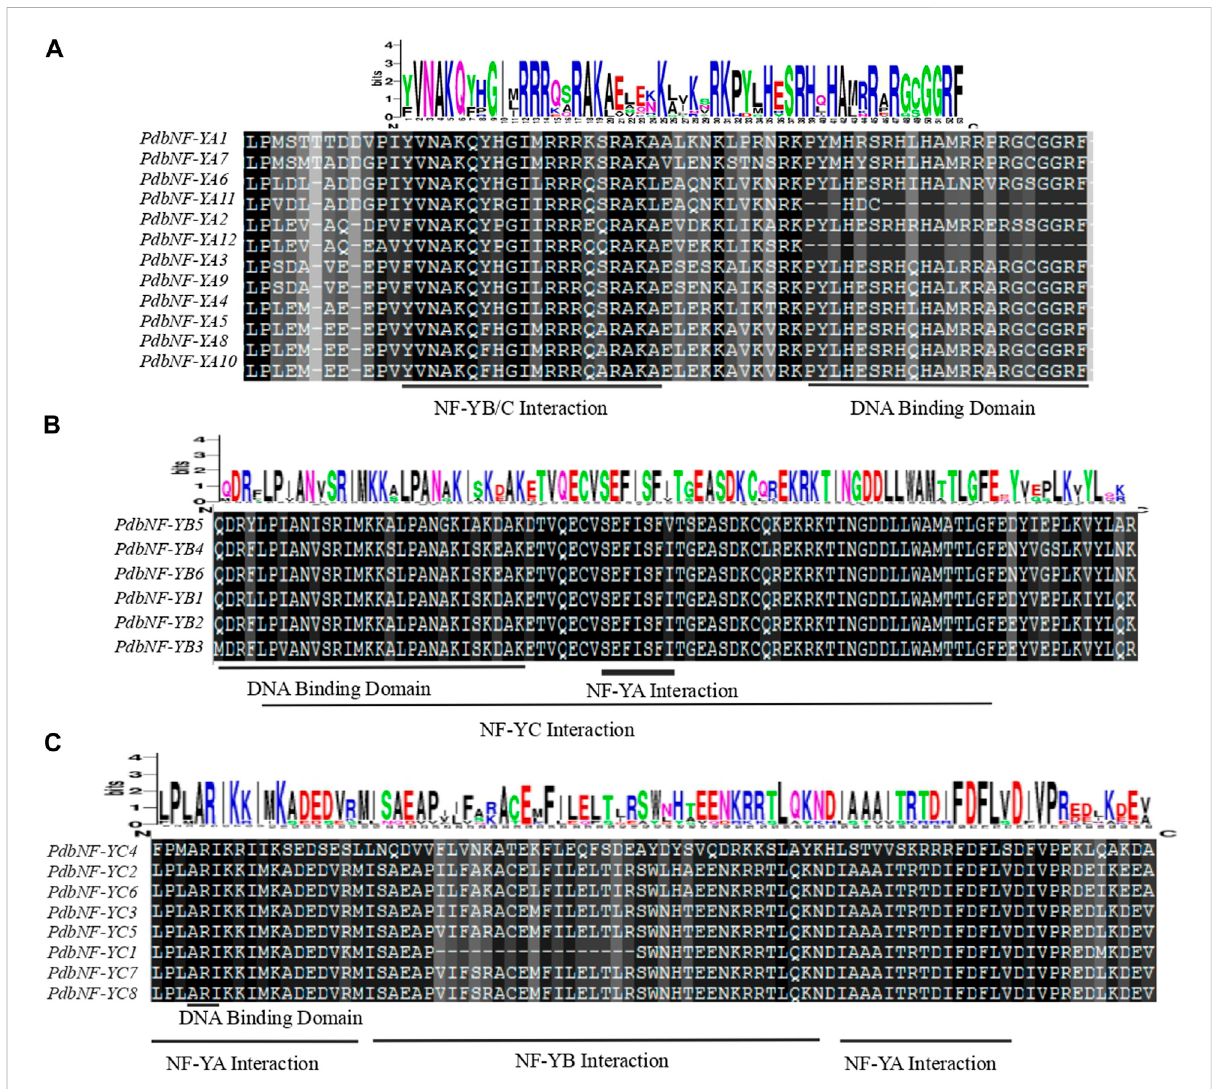
FIGURE 1 Multiplealignments ofthePdbNF-Y family. (A) Multiplealignments ofthePdbNF-YAconserveddomains. (B) MultiplealignmentsofthePdbNF- YB conserved domains. (C) Multiple alignments of the PdbNF-YC conserved domains. The logo of the conserved domains was visualized in